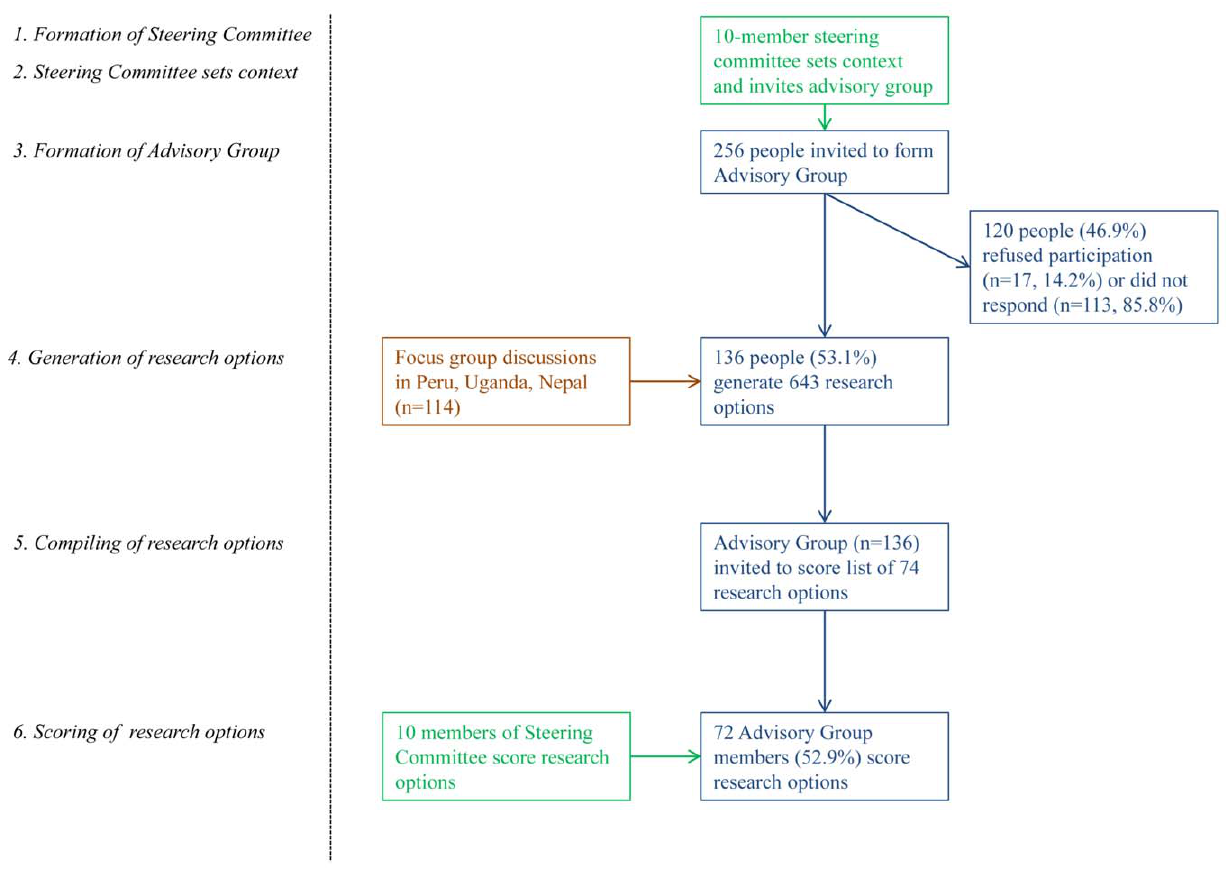
Figure 1. Research priority setting flow chart.